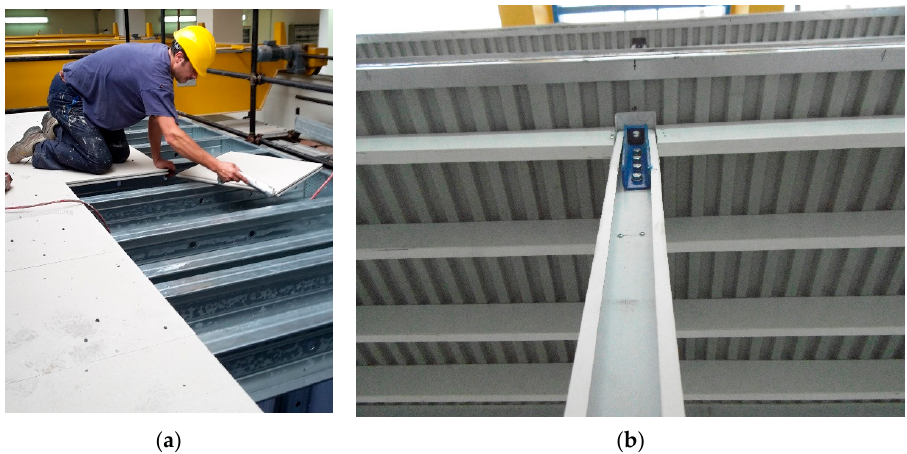
Figure 2. CFS structural systems: floors (a): Floor sheathing being placed on floor joists; (b): Hold- down connection between floors and walls.